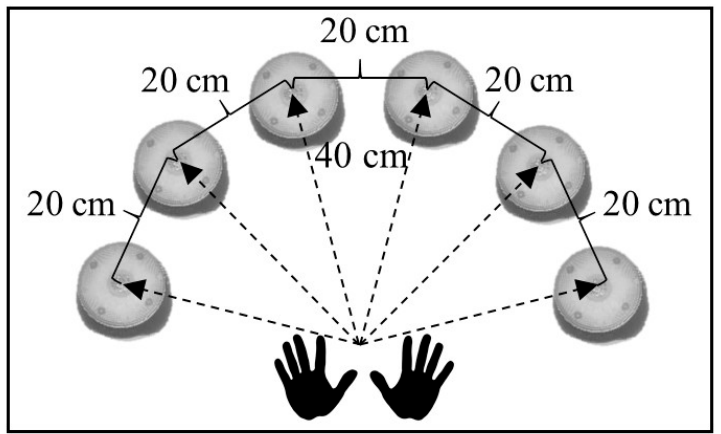
Figure 2. Distribution of devices in the reaction time